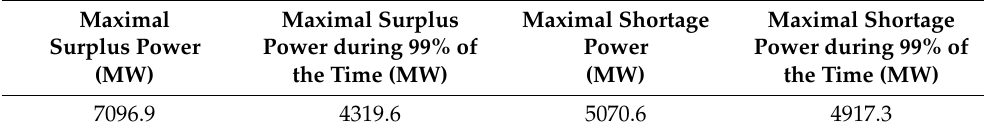
Figure 10. The imbalance power profile with surplus and shortage energy. Table 4. The imbalance power profile characteristics for the analyzed three-year reference time